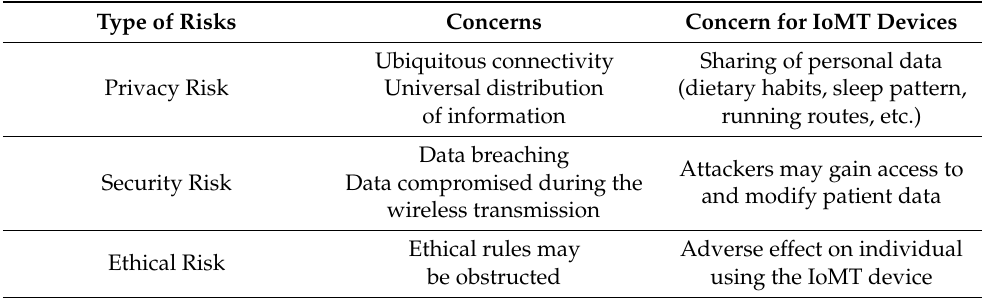
Table 1. Types of IoT risks [26,31]. Type of Risks